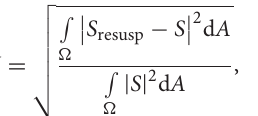
particles was kept fixed throughout each simulation. The spatial resolution of the sediment grid was 25 × 25 m for locations 1 and 3 and 10 × 10 m for location